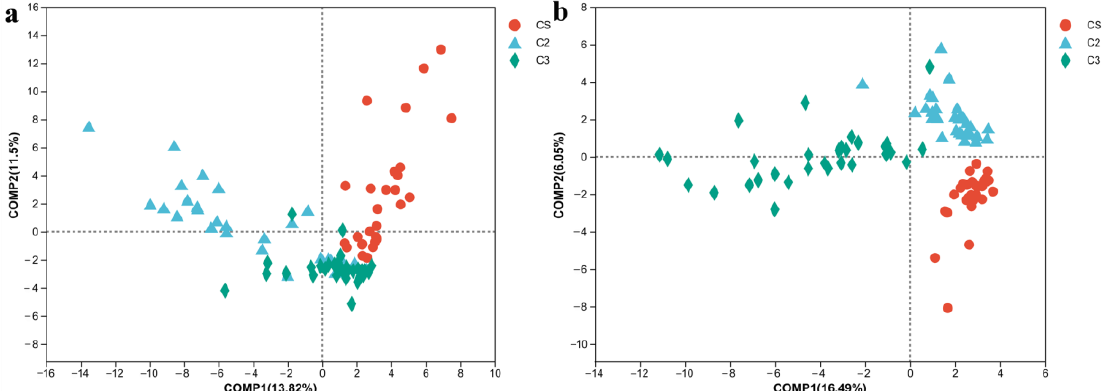
Figure 6. PLS-DA analysis of the microbial genera in the fermented grains during the sauce-flavor Baijiu manufacturing process. ( a ) bacteria. ( b ) fungi. CS, round 1b. C2, round 2. C3, round